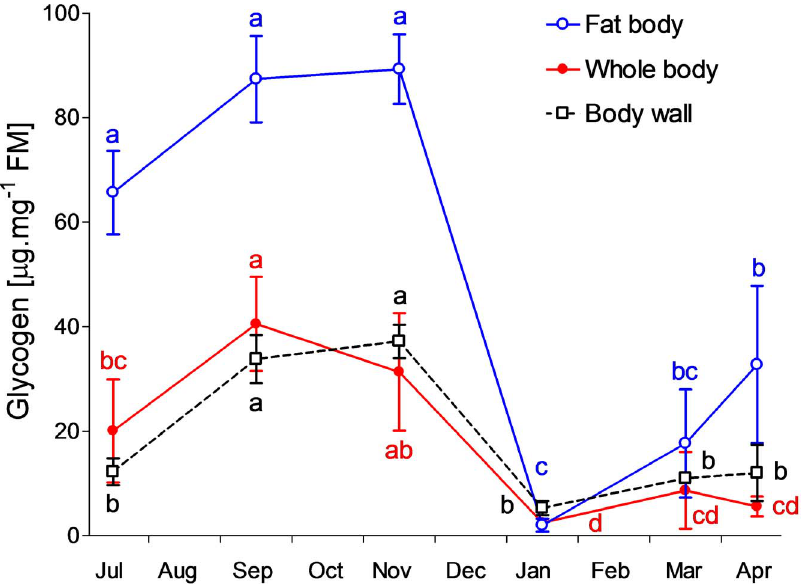
Figure 2. Glycogen. Seasonal whole-body and tissues changes of glycogen contents in field-sampled caterpillars of Cydia pomonella during 2010/ 2011. Each point is the mean 6 S.D. (whole body, n =5 individuals; tissues, n =3 replicates, 3 individuals each). Influence of sampling date on